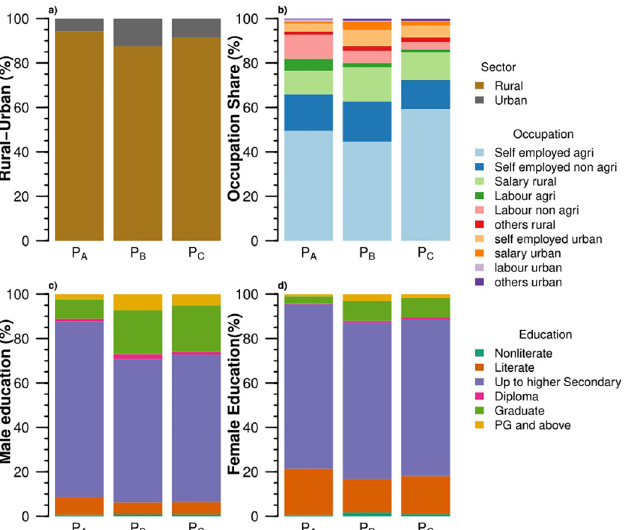
Fig 3. Socioeconomic features of Production-based food systems (P A , P B , and P C ) of India: (a) the share of rural-urban households, (b) the share of occupation classes, (c) the share of the highest education among male members, and (d) the share of the highest education among female